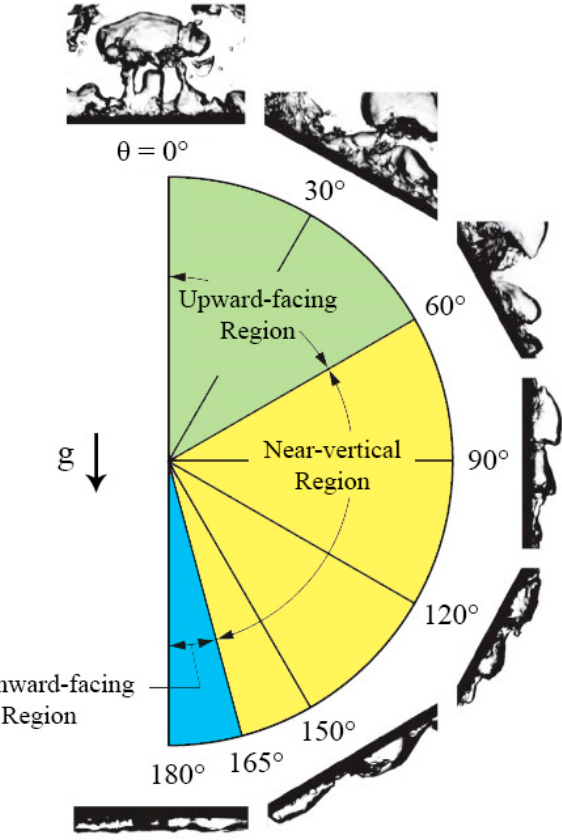
Figure 19. Pool boiling images and regions of various CHF mechanisms at diverse surface orientations. Adapted from Liang and Mudawar. Reproduced from [252], Elsevier: